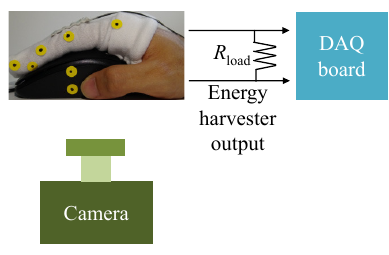
Figure 3. Experimental setup for a human finger.